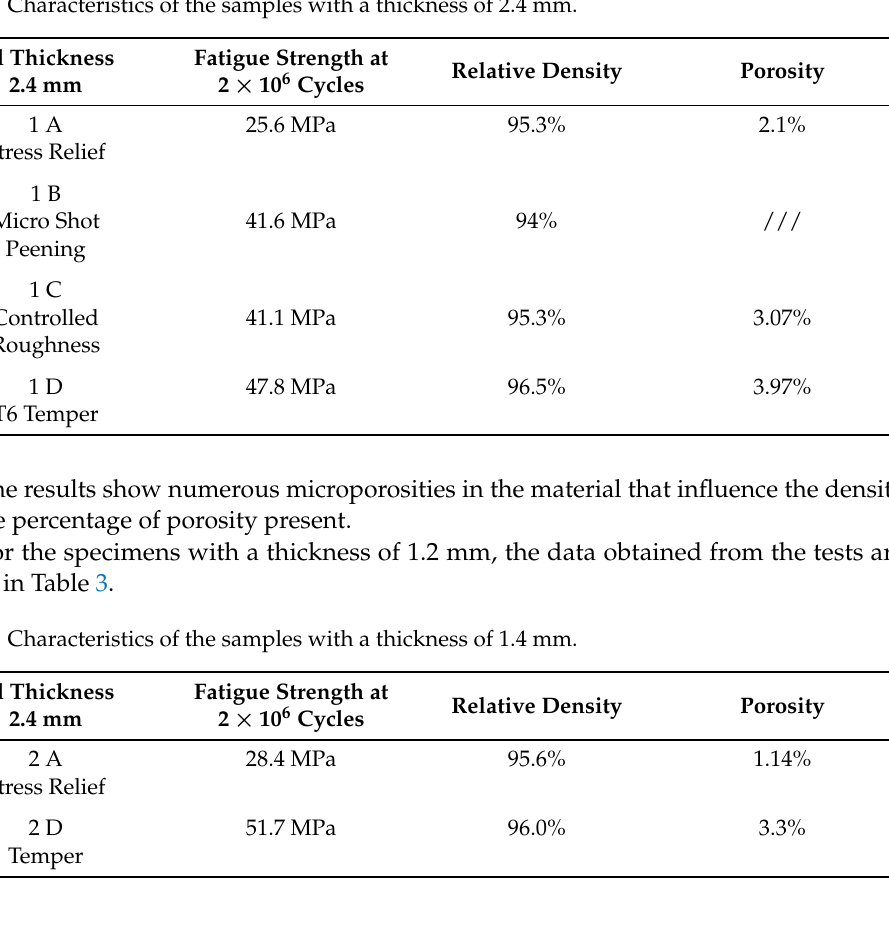
Table 2. Characteristics of the samples with a thickness of 2.4 mm.